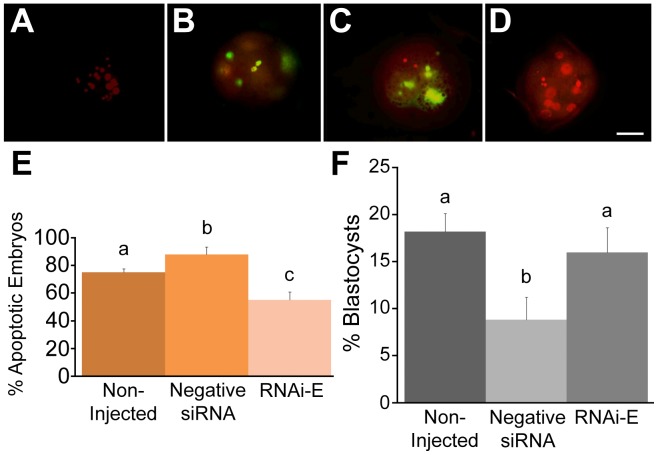
Knockdown of p66Shc ameliorates H2O2-induced apoptosis and developmental arrest of early bovine embryos.Groups of zygotes (n = 50/r, r = 3) were either: non-injected controls, injected with negative control siRNAs, or injected with p66Shc siRNA molecules (RNAi-E). At the 9–16 cell stage, all groups were subjected to 50 µM H2O2 treatment for 1 hr. After an overnight incubation, embryos were fixed and stained with a mixture of TUNEL labeling stain (green) and propidium iodide (red) to assess their apoptotic status. (A) Representative negative control embryo stained in the absence of active TUNEL enzyme. (B) Representative positive control embryo subjected to DNase treatment before TUNEL stain. (C) Representative apoptotic 9–16 cell embryo displaying TUNEL positive stain in conjunction with nuclear condensation and fragmentation. (D) Representative non-apoptotic 9–16 cell embryo displaying TUNEL negative staining in conjunction with intact nuclear staining. (E) Summary of the incidence of apoptosis following RNAi microinjection and H2O2 treatments. While embryos injected with negative siRNA molecules exhibited a greater proportion of apoptosis, embryos injected with RNAi-E exhibited a significantly reduced incidence of apoptosis. (F) The effect of p66Shc knockdown on the frequency of blastocyst formation following H2O2 treatment. Groups of embryos (non-injected, negative control siRNA- injected, or RNAi-E injected, were subjected to a 1 hr treatment of 50 µM H2O2 at the 2–4 cell stage after which they were allowed to develop until the 8th day of culture (192 hpi) at which point the frequency of blastocyst development was assessed. A significantly greater proportion of embryos injected with the p66Shc-specific siRNA molecules (RNAi-E) successfully developed into blastocysts compared to those injected with a negative control siRNA. The proportion of blastocysts amongst the RNAi-E group was comparable to that of the non-injected control group. Different letters above the histogram bars represent significant differences (p<0.05). Scale bar, 50 µM.